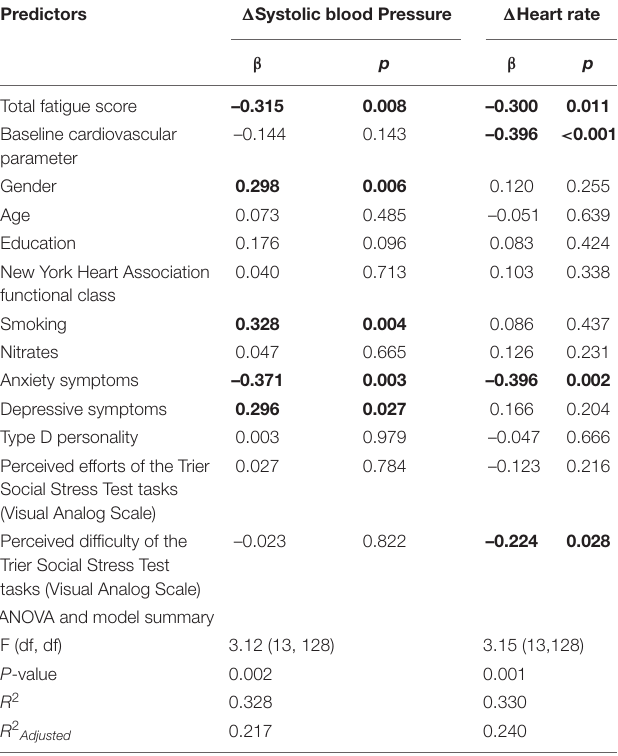
TABLE 7 | Multivariable Linear Regression model, examining total fatigue score associations with cardiovascular reactivity during Trier Social Stress Test anticipatory stress (task instruction), while controlling for possible